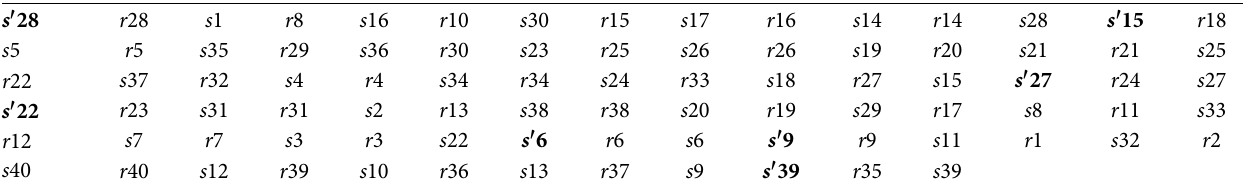
Figure 9: The gantry crane’s operation path for solution I. Table 7: The transshipment sequence for containers in solution